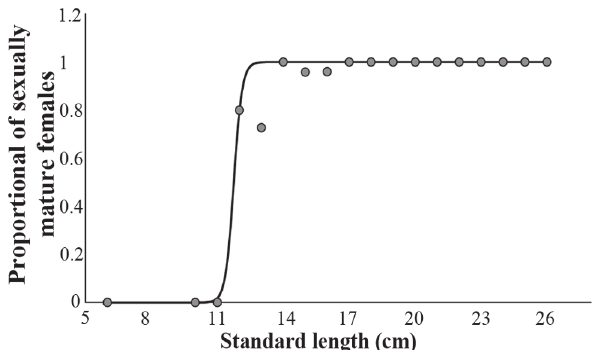
Fig. 11. Proportion of sexually mature Anableps anableps females by body size (standard length) collected in the mouth of the Maracanã River, Pará